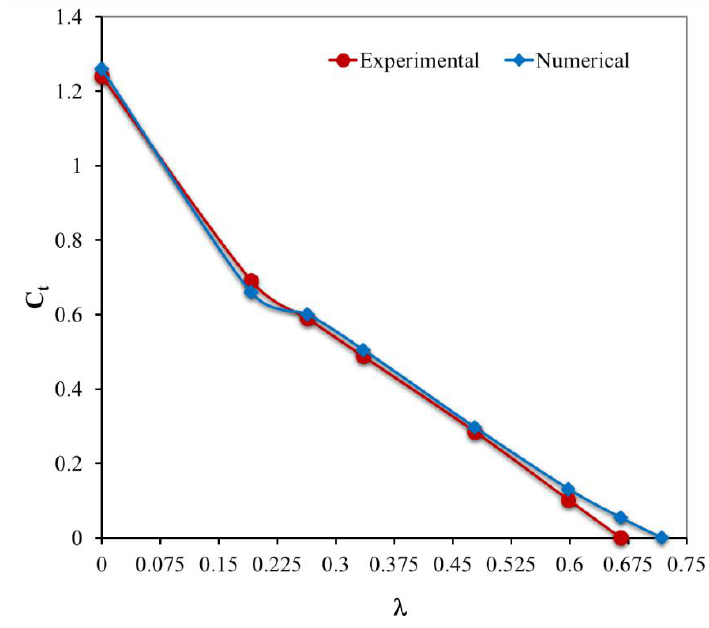
Figure 5. Validation of the numerical solution method with experimental data.